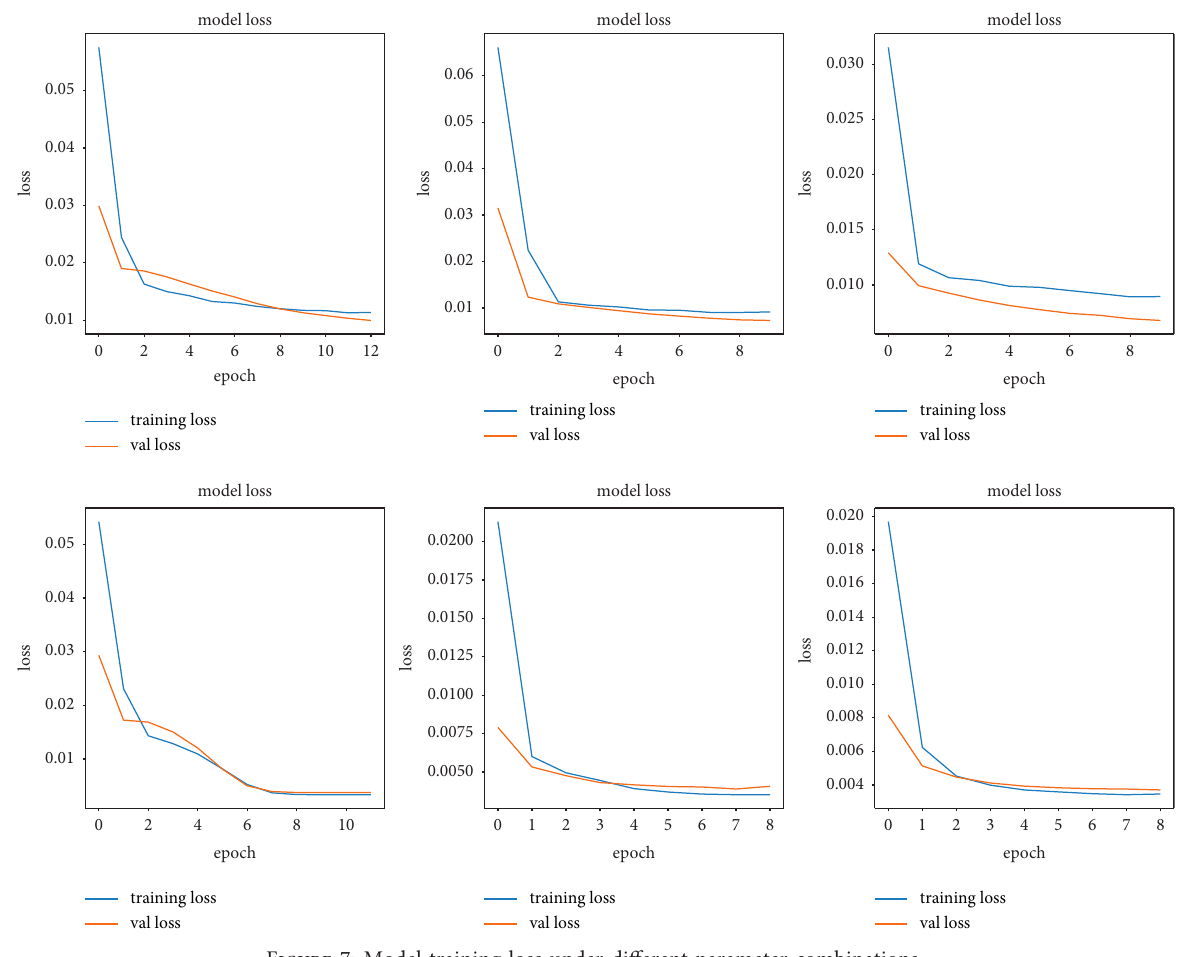
Figure 7: Model training loss under different parameter combinations. test data and test predict data